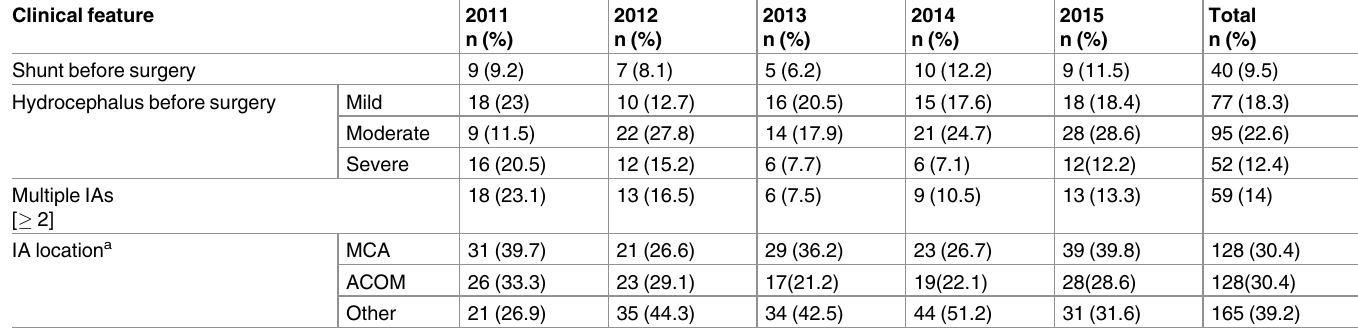
Anterior communicating artery (ACOM) and middle cerebral artery (MCA) were the most common sites of IA; each was present in 128 (30.4%) aSAH cases (Table 4). A total of 147 (35%) patients had moderate or severe hydrocephalus on admission (Table 4). On admission, 351 (83%) patients had GCS > 7, and 294 (70%) presented with HH score of 1 (47%) or 2 (23%) and 365 (87%) had a Fisher score (cid:20) 3 (Table 5). The medians of the duration of the surgery and bleeding volume were 60 (in 2011) and 50 (in 2012) minutes, and 150 cc (in 2011) and 150 cc (in 2012), respectively. In year 2015, the 6-month survival rate was 89.8%; only 10 (10.2%) patients died within six months of surgery. Table 4. Location and other featuresof